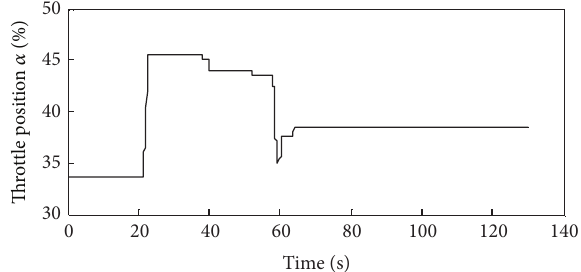
Figure 18: Throttle position of engine operation conditions.